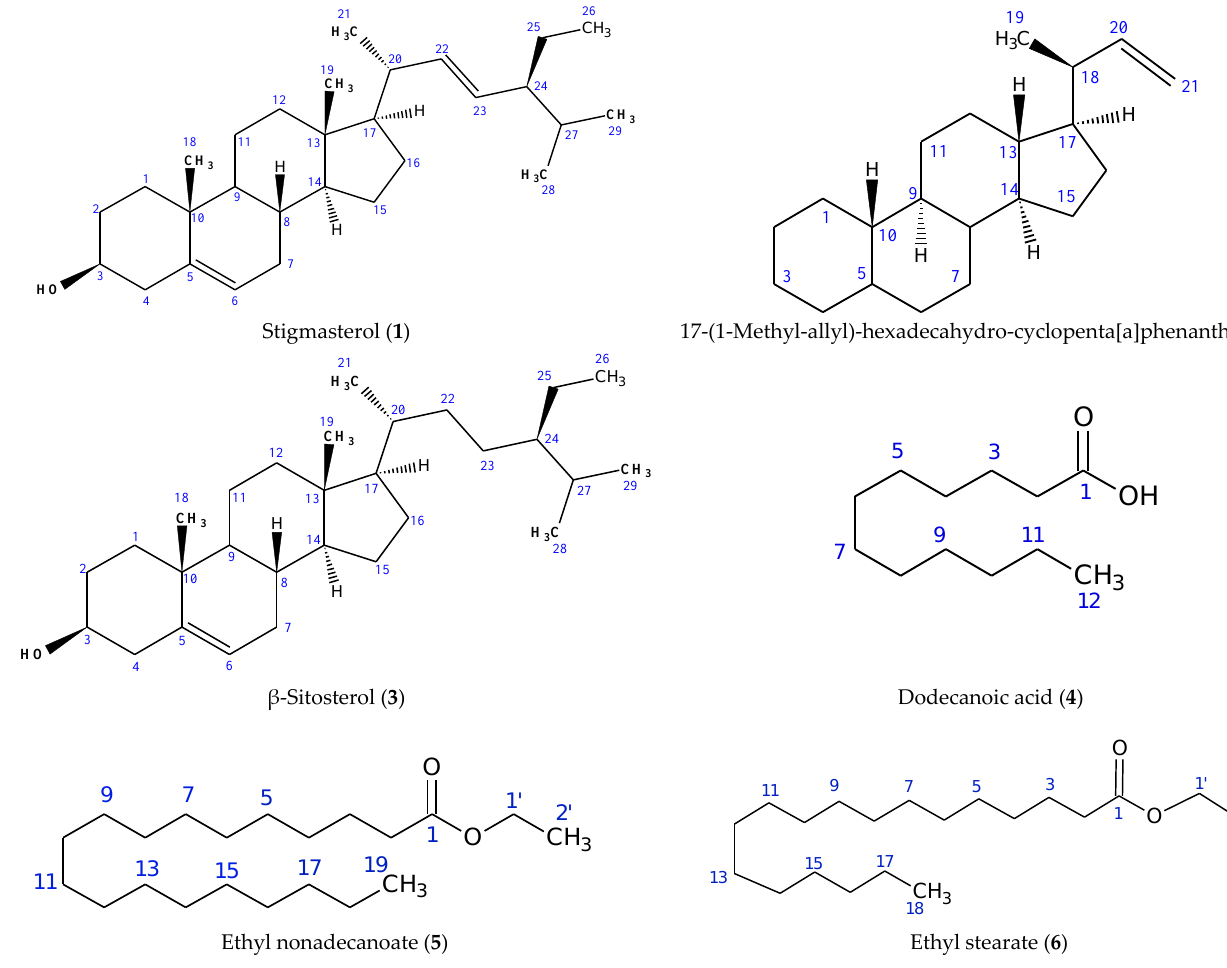
Figure 1. Structures of Compounds 1 – 6 Isolated from Cyperus sexangularis Leaf